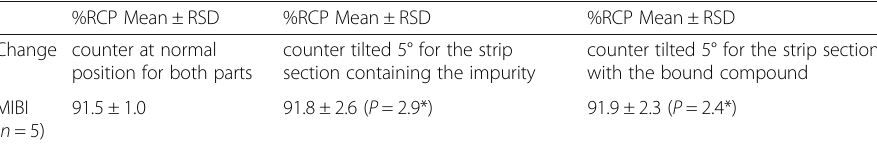
Table 5 Robustness of the counter %RCP Mean ± RSD Change counter at normal counter tilted 5° for the strip position for both parts section containing the impurity